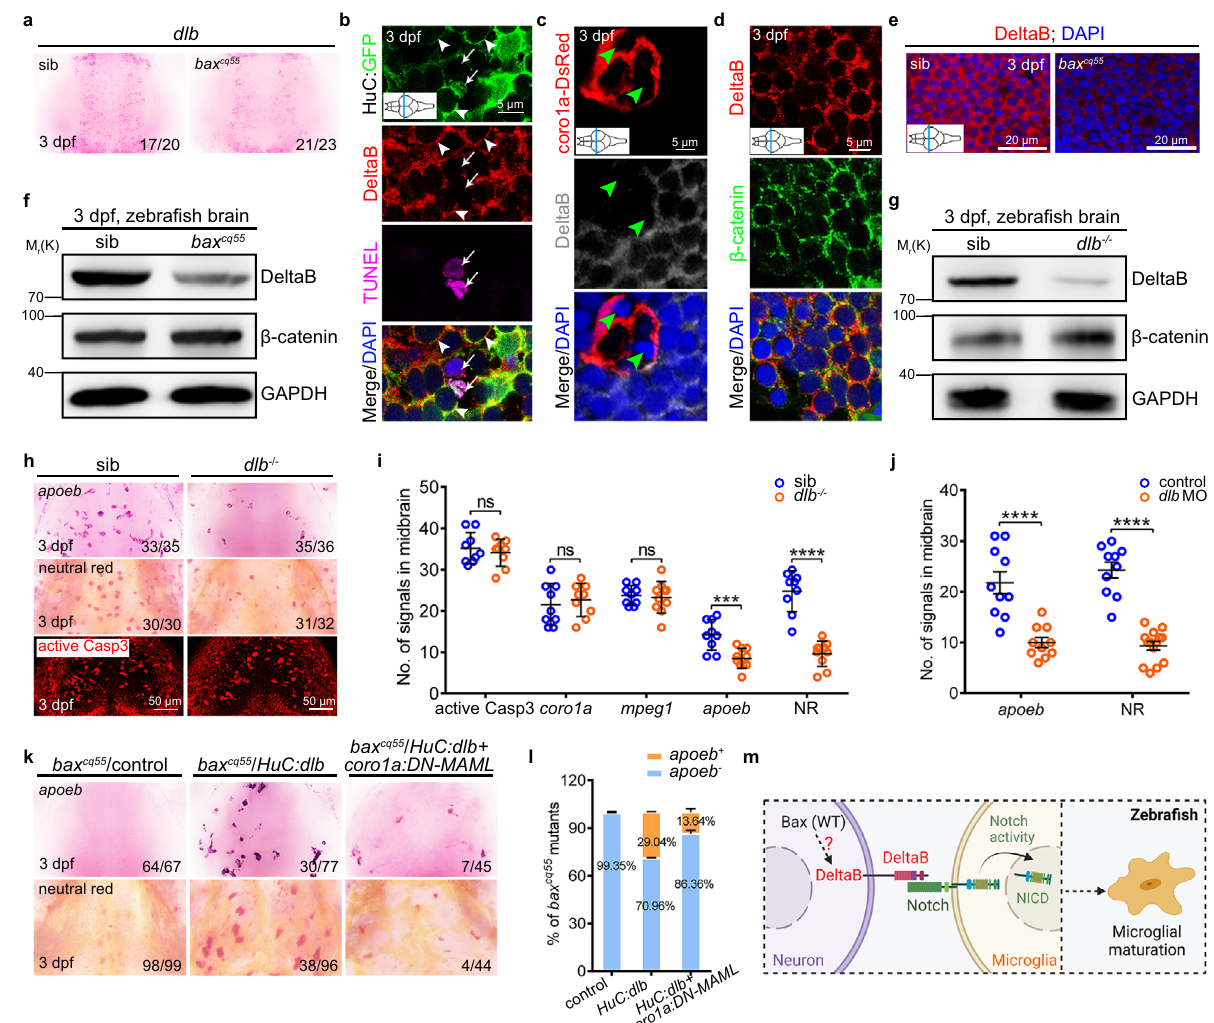
Fig. 4 | Neuronal DeltaB serves as a key ligand triggering Notch activation in microglia. a WISH of dlb in 3 dpf midbrains. b – d Immuno fl uorescence of HuC- GFP (green) with DeltaB (red) and TUNEL (magenta) ( b ) or coro1a-DsRed (red) with DeltaB (gray) ( c ) or DeltaB (red) with β -catenin (green) ( d ) in the transverse sections of 3 dpf midbrains. DeltaB mainly co-localized with the GFP + signals in membrane (white arrowhead), rarely with DsRed + , neither TUNEL signals (white arrow),nor non-phagocytizedcells (green arrowhead). e Immuno fl uorescenceof DeltaB in the transverse sections of 3 dpf midbrains. f , g WB of DeltaB, β -catenin andGAPDHin bax cq55 ( f )and dlb -/- ( g ).Theexperimentswererepeatedthree times andtheresultsweresimilar. h Representativeimagesof apoeb WISH,NRstaining, and active Casp3 immuno fl uorescence in 3 dpf midbrains. i , j Quanti fi cation of active Casp3 + , coro1a + , mpeg1 + , apoeb + , and NR + signals in siblings and dlb -/ - ( i , active Casp3, coro1a : n =9 per group; mpeg1 , apoeb , NR: sib: n =9, dlb -/- : n =10